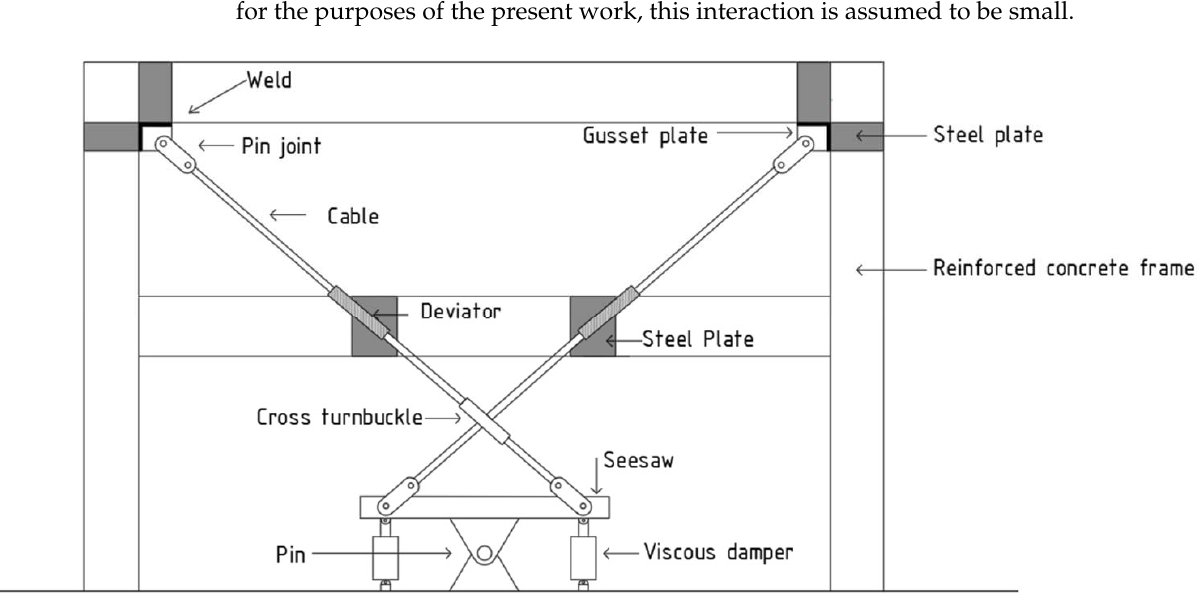
Figure 1. Installation and connection details of a seesaw system within an RC frame.